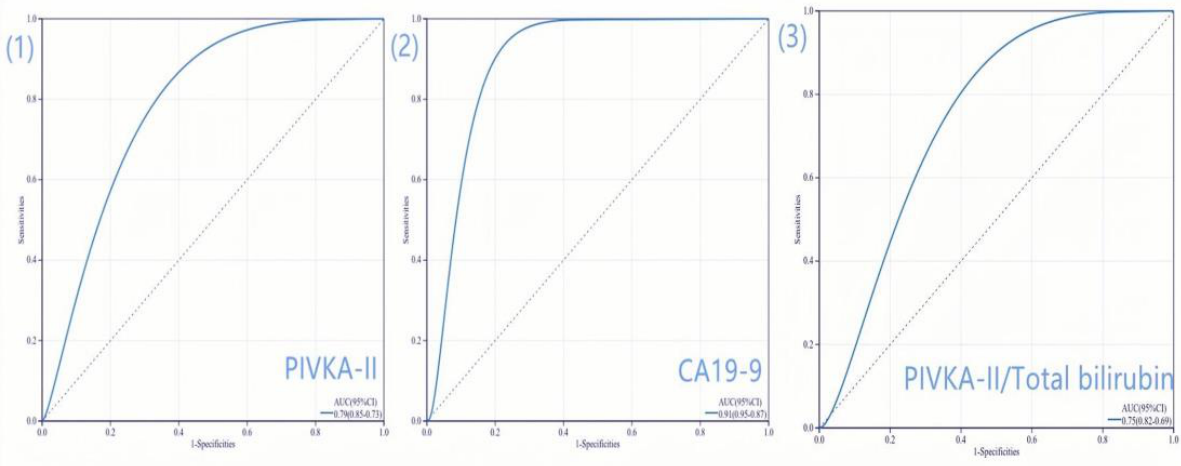
Figure 3. ROC curves for pancreatic ductal adenocarcinoma diagnosis. ( 1 ) ROC curve of PIVKA-II for PDAC diagnosis; ( 2 ) ROC curve of CA19-9 for PDAC diagnosis; ( 3 ) ROC curve of PIVKA-II/Total bilirubin for PDAC diagnosis. ROC, Receiver operating characteristics; PIVKA-II, protein induced by vitamin K absence-II, CA19-9, carbohydrate antigen 19-9; AUC, the area under the curve; PDAC, pancreatic ductal adenocarcinoma.